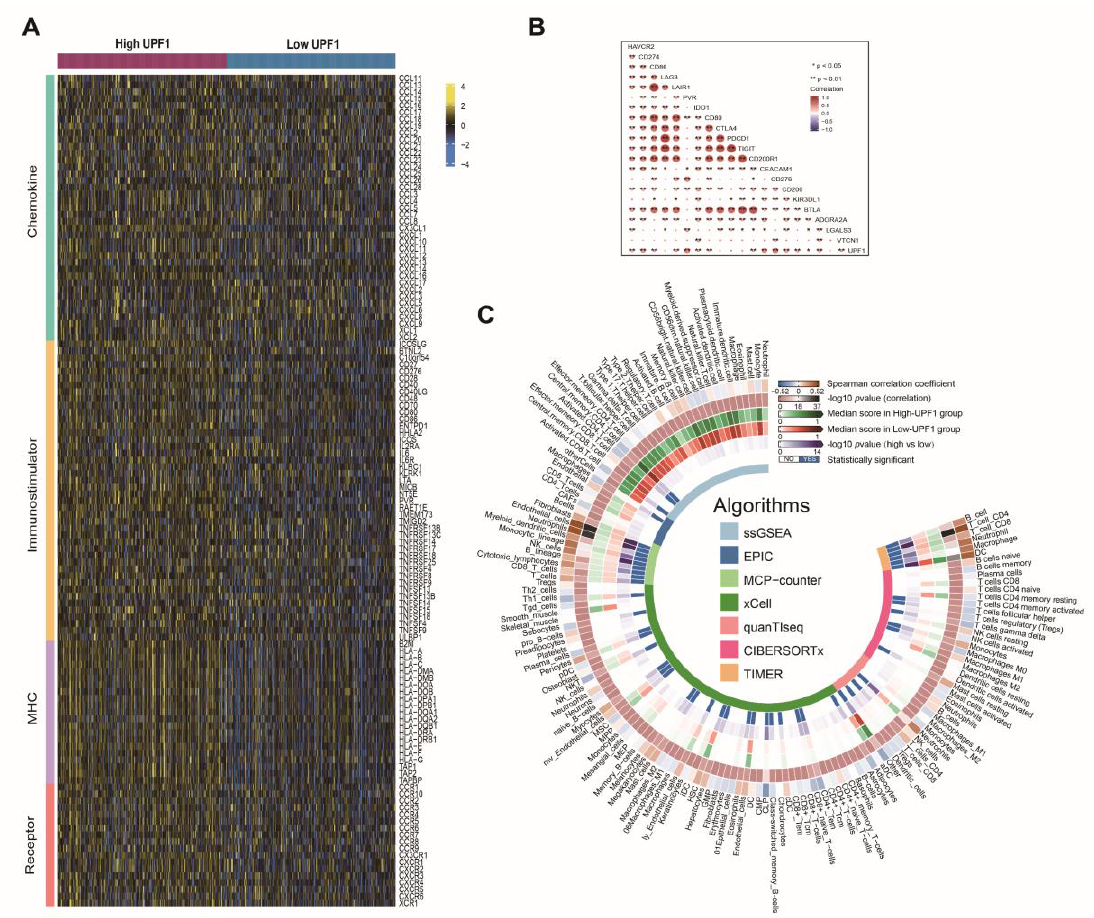
Figure 3. The effects of UPF1 in the ccRCC tumor microenvironment. ( A ) High-UPF1 and low-UPF1 groups of ccRCC express different immunomodulators (chemokines, receptors, MHC, and immunostimulators). ( B ) Identifying the 20 inhibitory immune checkpoints associated with UPF1. ( C ) Immune cells characteristics in ccRCC of high-UPF1 and low-UPF1 groups: The outermost ring represented the correlations between immune cell infiltration levels and UPF1 expression levels; The second outer ring represented the p values of correlation coefficients; The third and fourth outer rings represented the median infiltration level of immunocytes in high-UPF1 group and low-UPF1 group; The fifth and sixth outer ring represented the p value of differences between immunocyte infiltration levels between high-UPF1 and low-UPF1 groups. The inner ring represented the according algorithms that we employed.